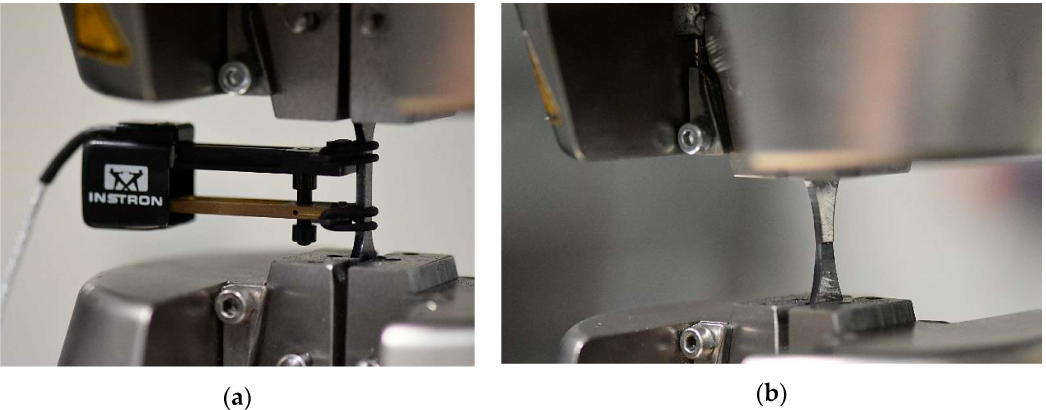
Figure 2. Flat ( a ) and hourglass ( b ) mini-specimen in testing machine before tensile and fatigue test, respectively, nominal dimensions of the cross sections in measuring zones: 4 mm × 2 mm ( a ); 4 mm × 3 mm ( b